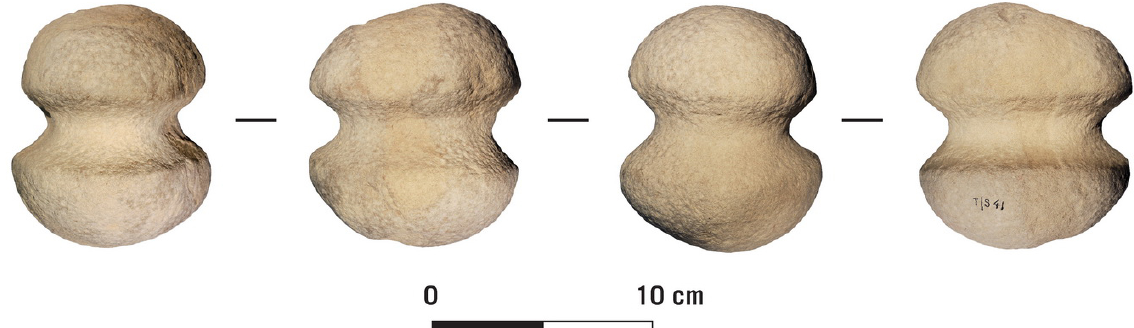
Figure 4. Lithic hammerstone ID 9116 observed in four different views. Its characteristic is the deep gorge that surrounds the whole lithic body.